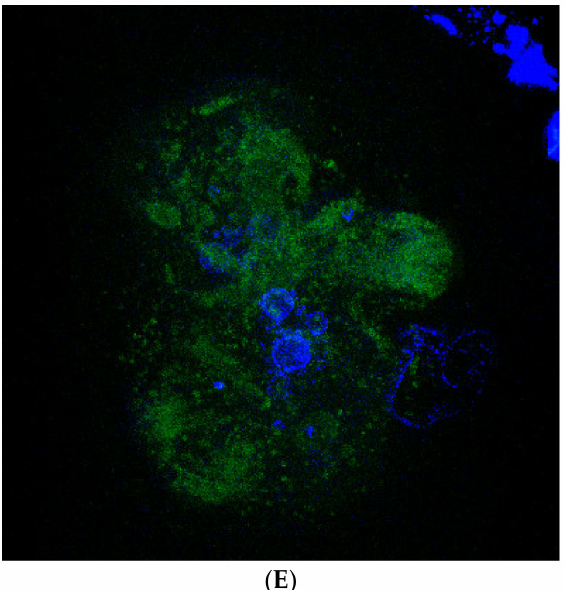
Figure 1. GPx4 presence in the rat oocyte and preimplantation embryos. ( A ) Shows the rat oocyte with cumular cells on D1 detected under a confocal microscope. The immunofluorescent analysis showed homogeneously distributed GPx4 in the cytoplasm of the oocyte and cumular cells (arrows). ( B ) Shows the rat zygote on D1. The immunofluorescent analysis shows the beginning of GPx4 cluster formation in the cytoplasm of the zygote on D1, detected under a confocal microscope. ( C ) Shows the rat 2-cell embryo on D3. The immunofluorescent analysis shows GPx4 clusters in the cytoplasm of the 2-cell embryo on D3, detected under a confocal microscope. Clusters are mostly in perinuclear space, less on the periphery. ( D ) Shows the rat blastocyst on D5. The immunofluorescent analysis shows GPx4 clusters in the cytoplasm of the blastocyst on D5, detected under a confocal microscope. Clusters are mostly in perinuclear space. ( E ) Shows the rat degenerated embryo. The immunofluorescent analysis shows a combination of homogeneous distribution and cluster formation of GPx4 detected under a confocal microscope. Blue represents DNA identified by Hoechst 33342; green shows GPx4 identified by an anti-GPx4 antibody conjugated with fluorescein isothiocyanate (FITC); GPx4 is glutathione peroxidase 4; D1, D3, and D5 refer to the corresponding days of